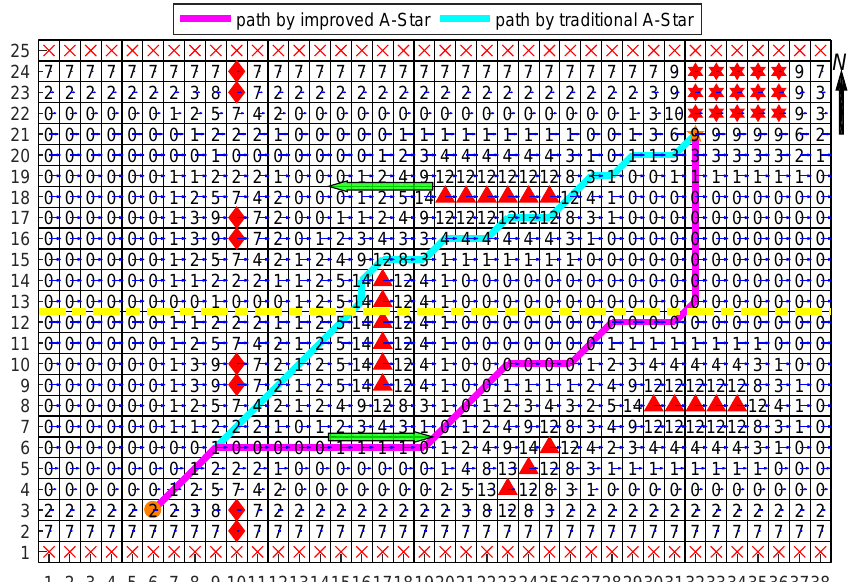
Figure 8. Normal path generation with a traditional A-Star algorithm and an improved A-Star algorithm for vessels (The definition of the graphic symbols in this figure is the same as the definition in Figure